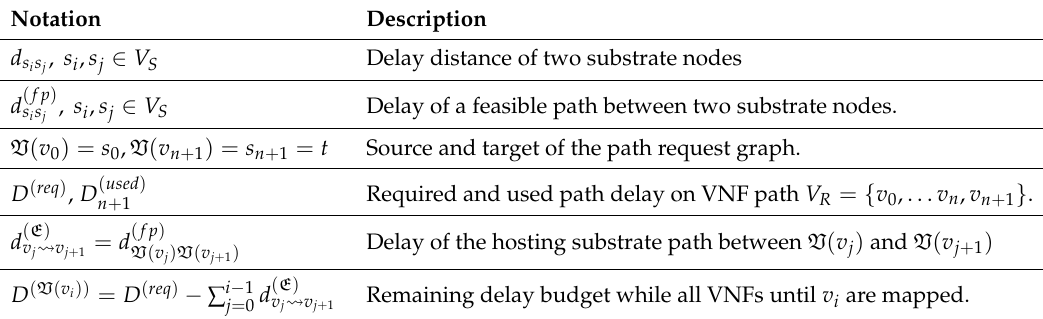
Table 3. Notations for the end-to-end latency